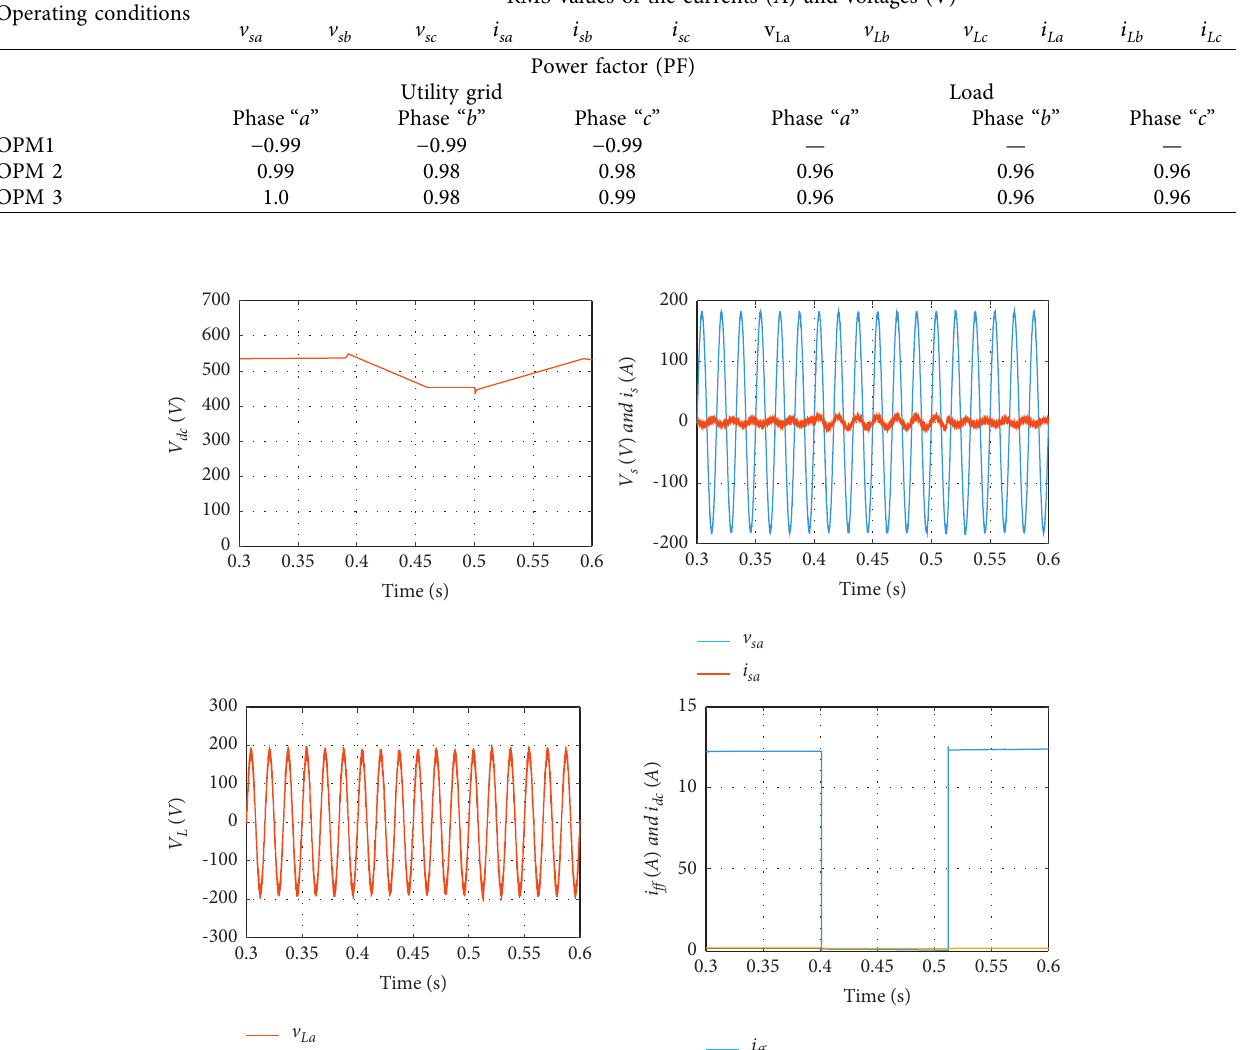
> P L . Voltage of dc bus V dc , wind − pv for sudden wind wind − pv